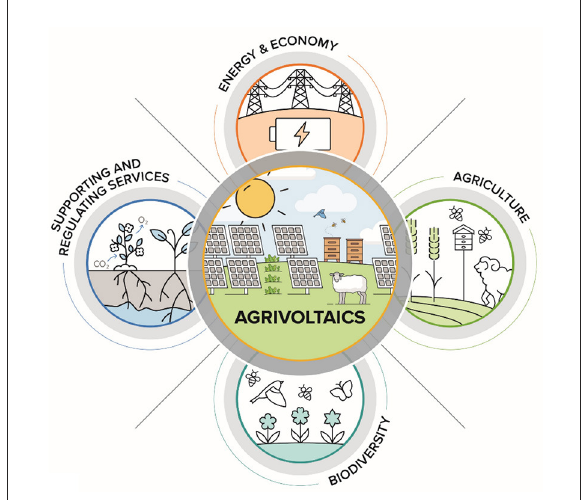
FIGURE1 Ecosystem Services of Agrivoltaic Systems. Agrivoltaic (AV) systems have the potential to influence many different ecosystem services depending on priorities and implementation goals. Most clearly, AV systems produce electricity and thus contribute directly to energy and economy (top circle, Section Energy and economy). AV system configurations can also support other services. Crops and livestock can be grown or supported on land co-located with AV systems (right circle, Section Agricultural production); natural habitat implemented at AV systems can support plant and animal biodiversity to help achieve conservation goals (bottom circle, Section Biodiversity); thoughtful management can also result in beneficial supporting and regulating services, including net primary production, carbon sequestration and water and soil conservation (left circle, Section Supporting and regulating services). These different ecosystem services are not mutually exclusive, and thoughtfully designed AV systems could result in multiple